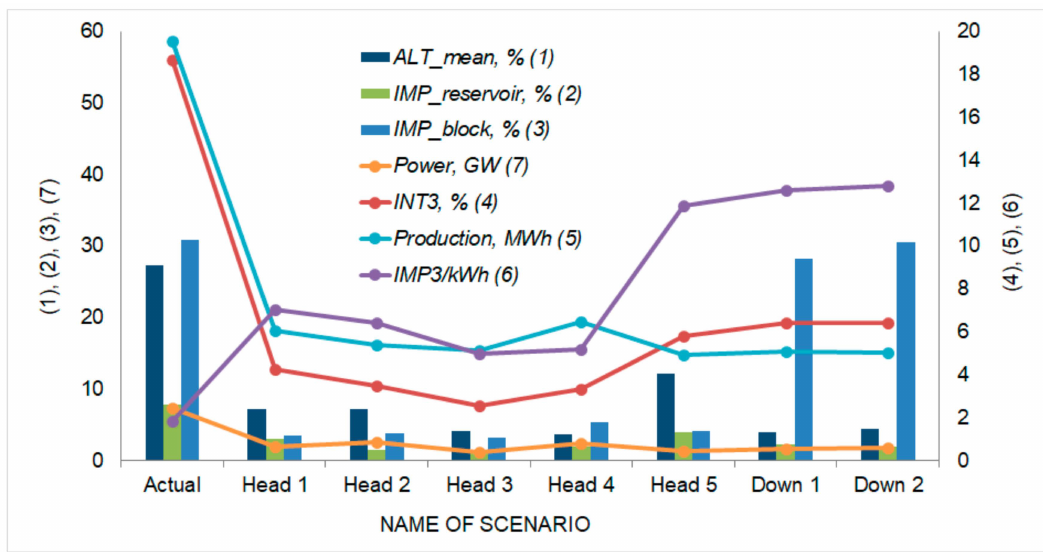
Figure 5. Relationship between the impact factors in scenarios when dams are located in the upper (Up) and lower (Down) parts of the Amur